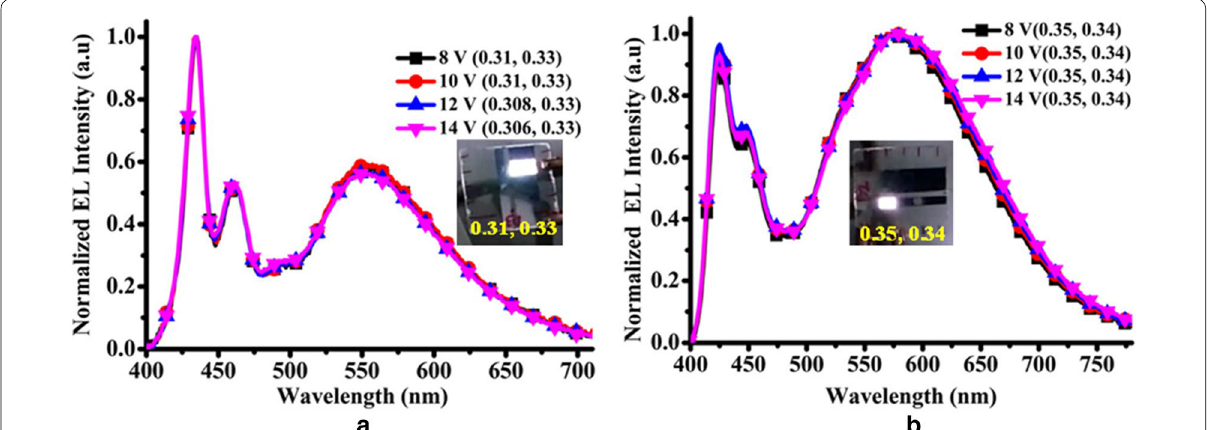
Fig. 14 EL spectra of WDP-1 ( a ) and WDT-1 ( b ) copolymers based WPLEDs at different driving voltages (Reproduced with permission from Ref. [45] Copyright © 2017, American Chemical